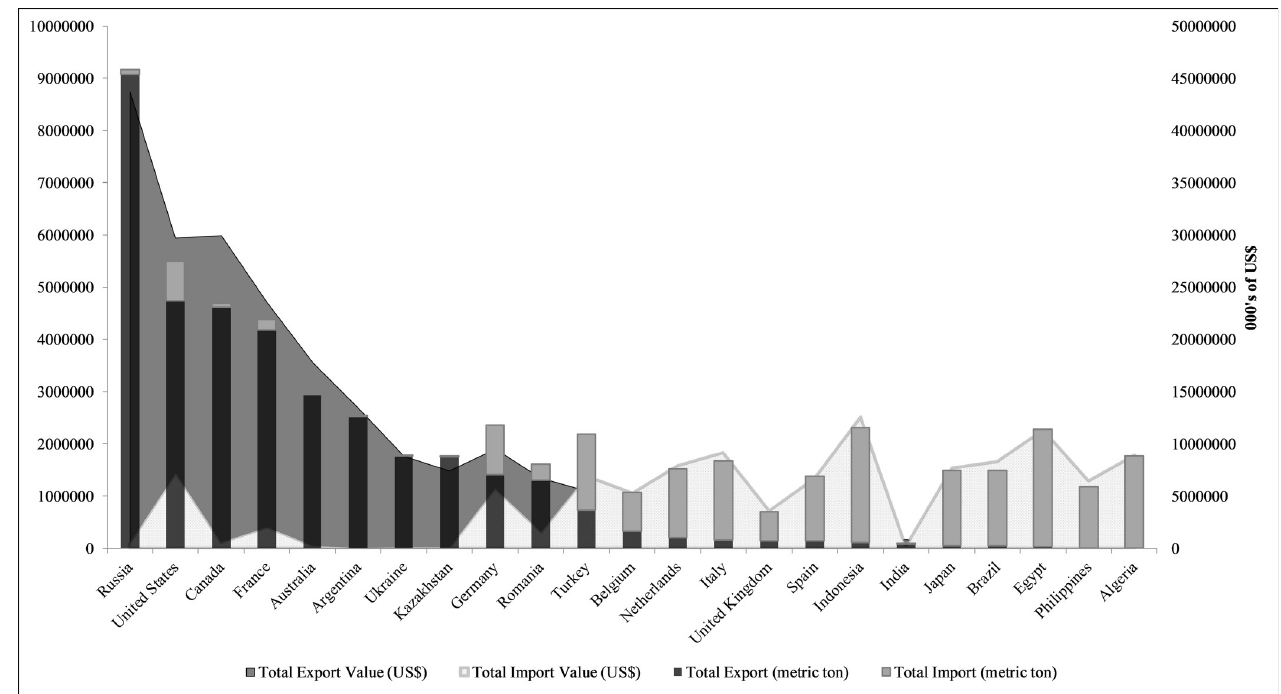
Fig 2. Top 10 countries by volume and value of